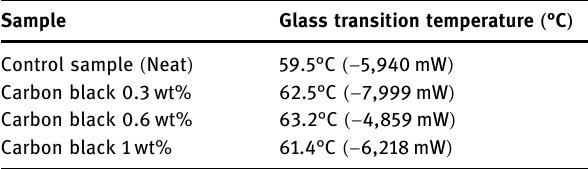
Table 1: DSC glass transition temperature and crystallizations onset temperatures of Neat and 0.3, 0.6 and 1 wt% carbon black added